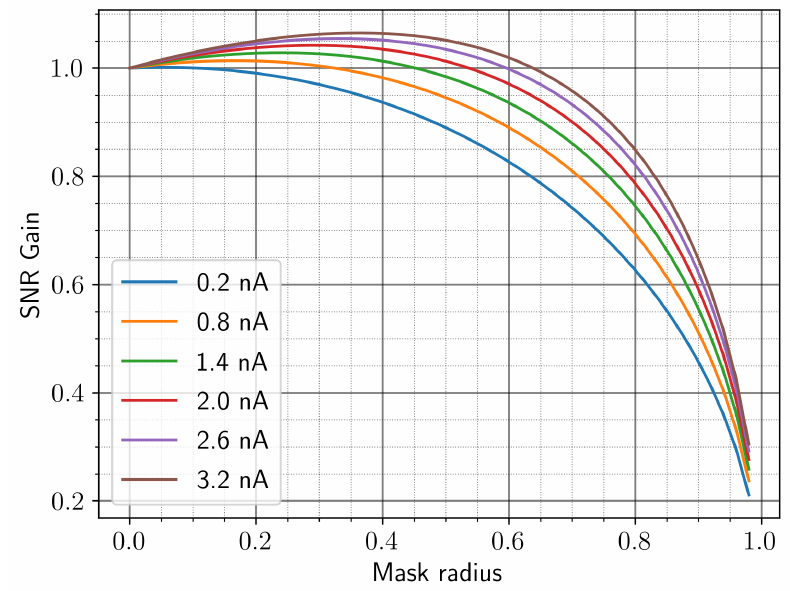
Figure 9. The SNR gain as function of mask radius for different incoming currents. The SNR gain is defined as the ratio of the SNR with the SNR when the mask radius is